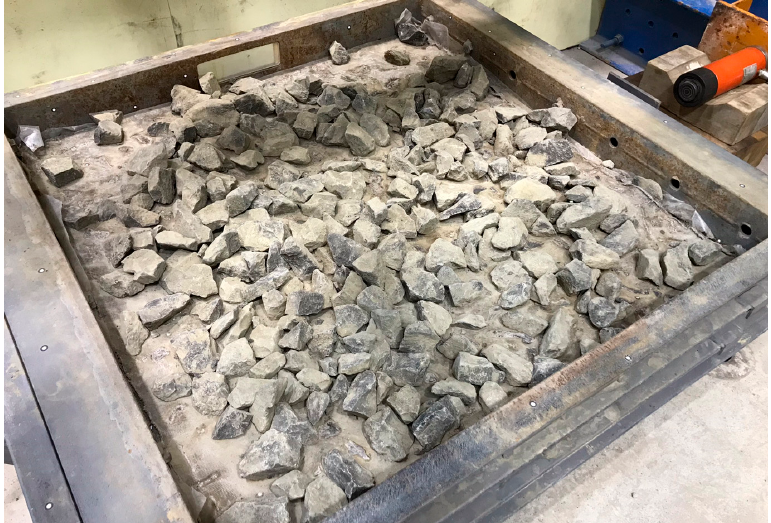
Figure 1. The ballast particles are cemented into the CC layer in a multi-level shear box.